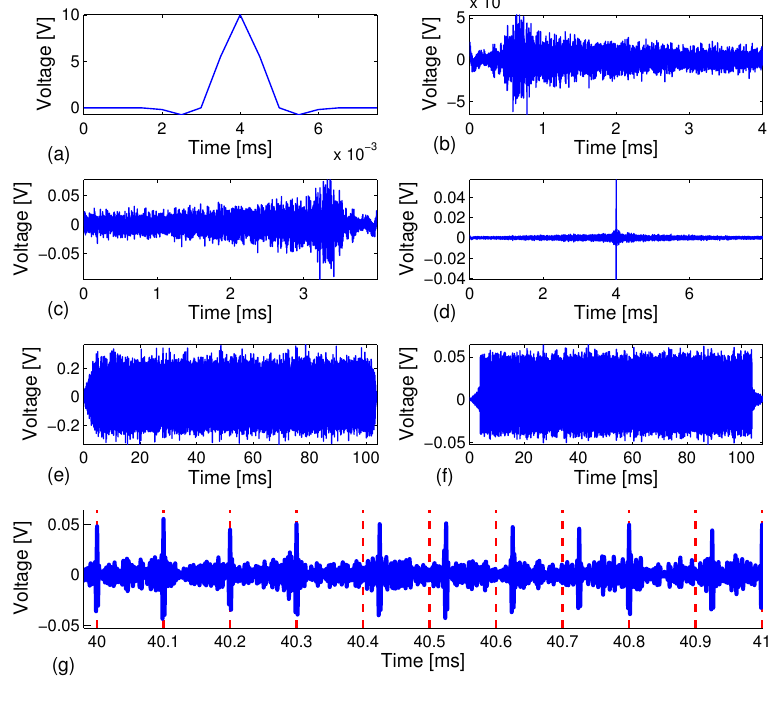
Figure 3. Snapshots of waveforms obtained experimentally from time reversal-based pulse position modulation (TR-PPM) data communications at a data rate of 10 kbps. ( a ) Gaussian pilot signal of 8 µs ; ( b ) received response after channel sounding; ( c ) time reversal transmission; ( d ) received time reversal focused waveform; ( e ) modulated time reversal PPM waveform; ( f ) received information carrying waveforms; and ( g ) zoomed-in plot of ( f ). The red dashed lines indicate the starting positions of symbol frames. The recovered bit stream in the time window of 40 ms - 41 ms is [0 0 0 0 1 1 1 1 0 1] .